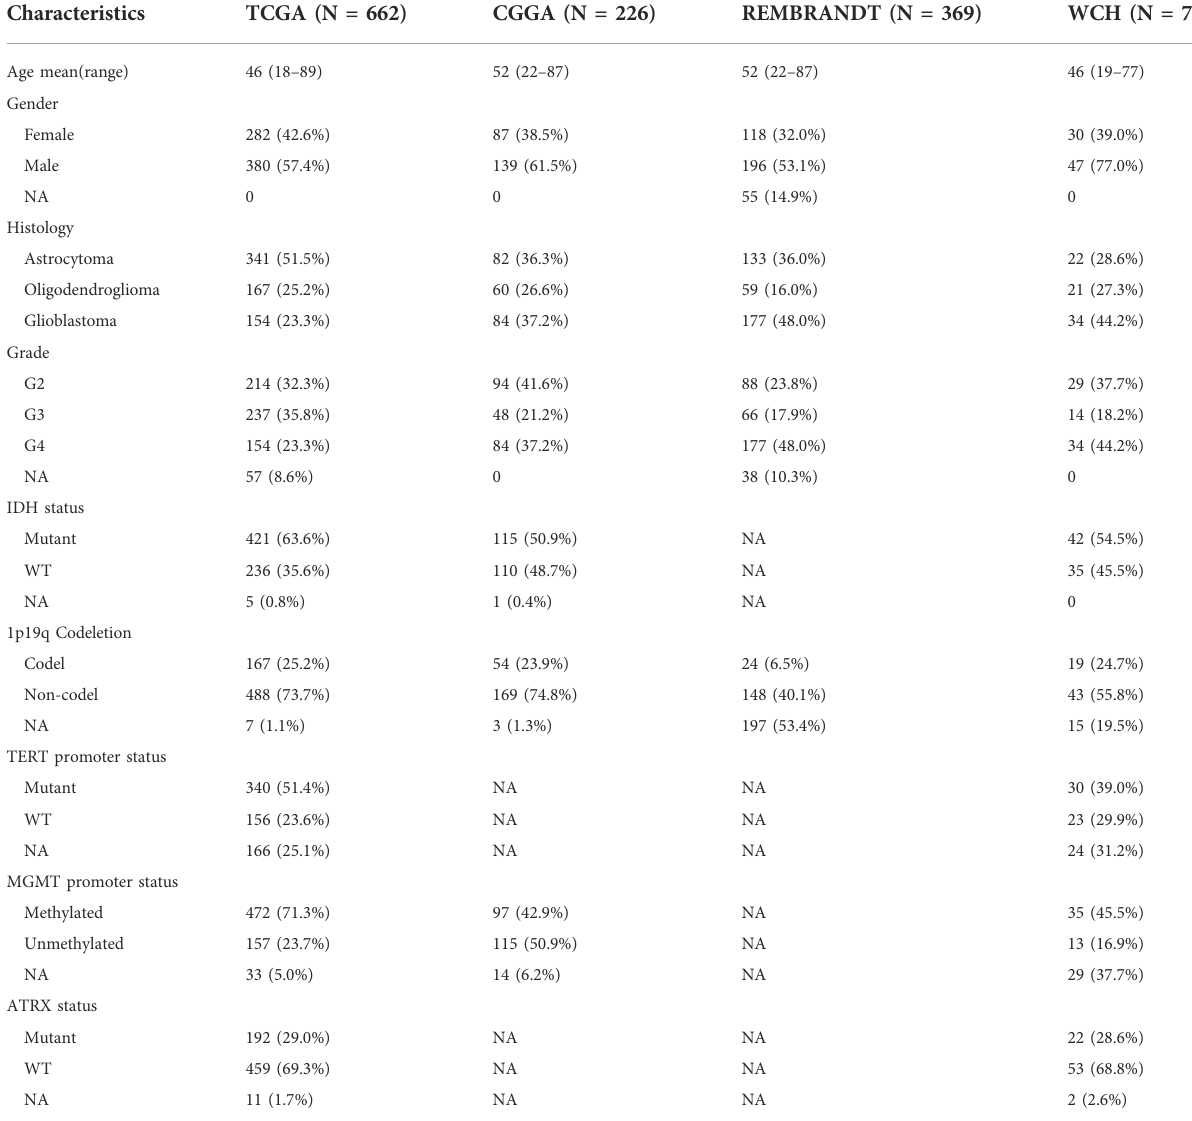
TABLE 1 Clinicopathological characteristics of adult primary glioma patients in TCGA, CCGA, REMBRANDT, and WCH cohort.